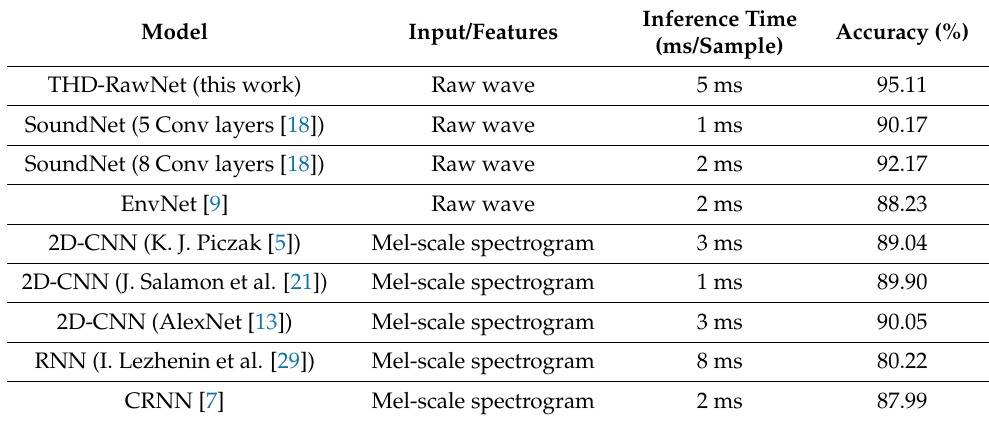
Table 3. Performance of the proposed THD-RawNet and baseline models on the THD